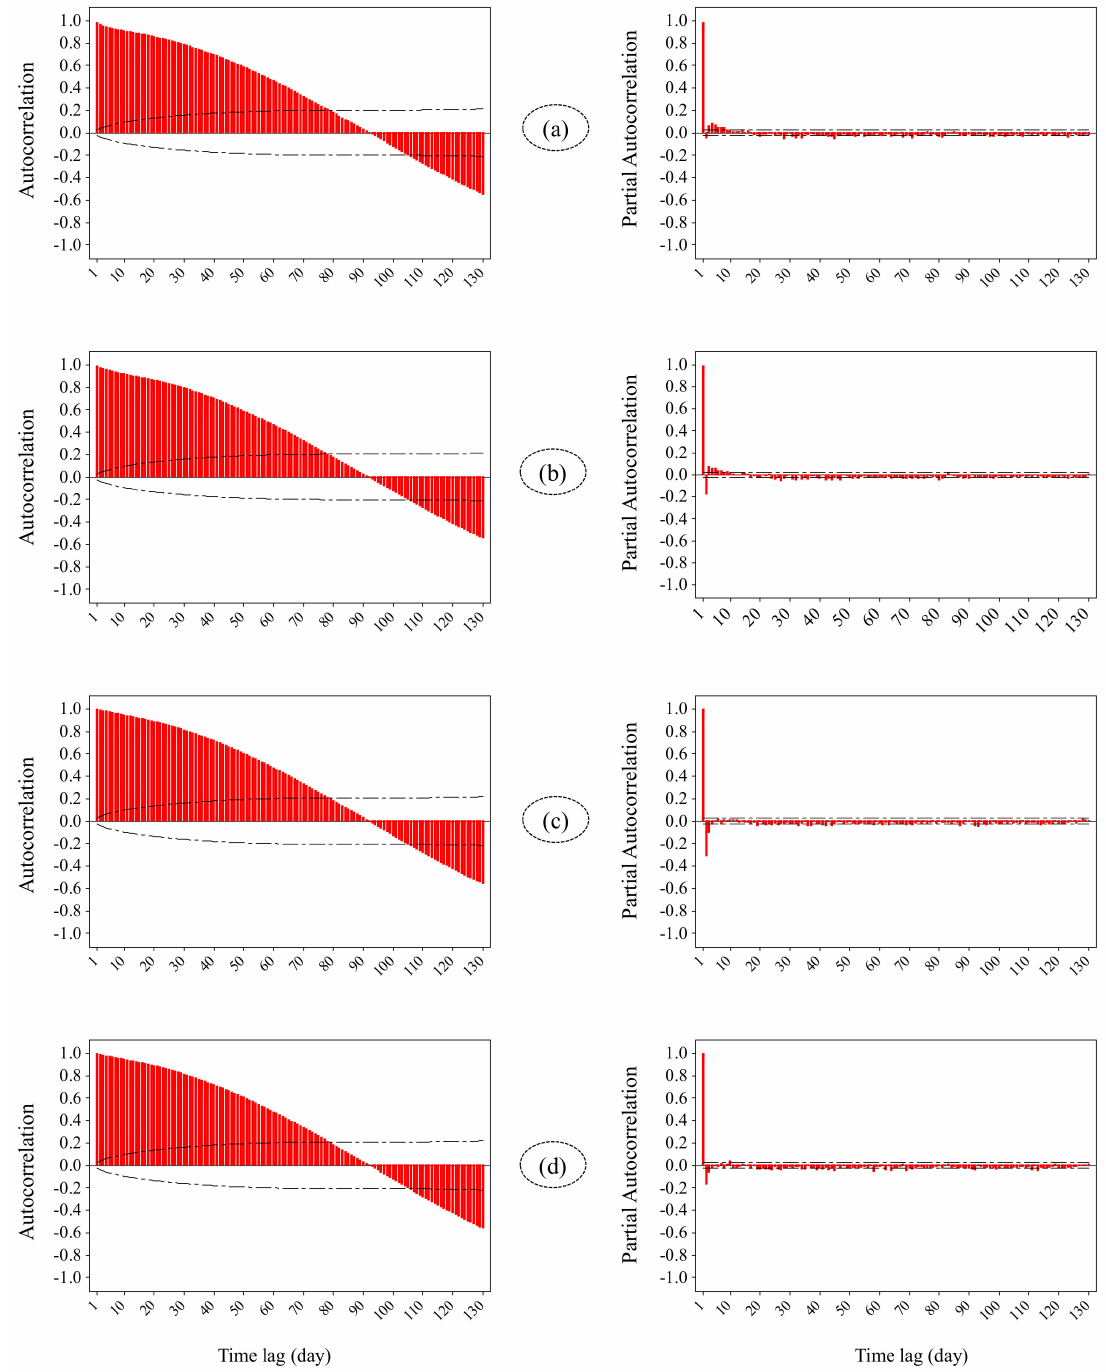
Figure 6. Graphs of Autocorrelation (ACF) and Partial Autocorrelation (ACF) for the TRW time series. The alphabets refer to the hydrometric stations: ( a ) Bobry, ( b ) Sieradz, ( c ) Pozna´n and ( d ) Gorzow